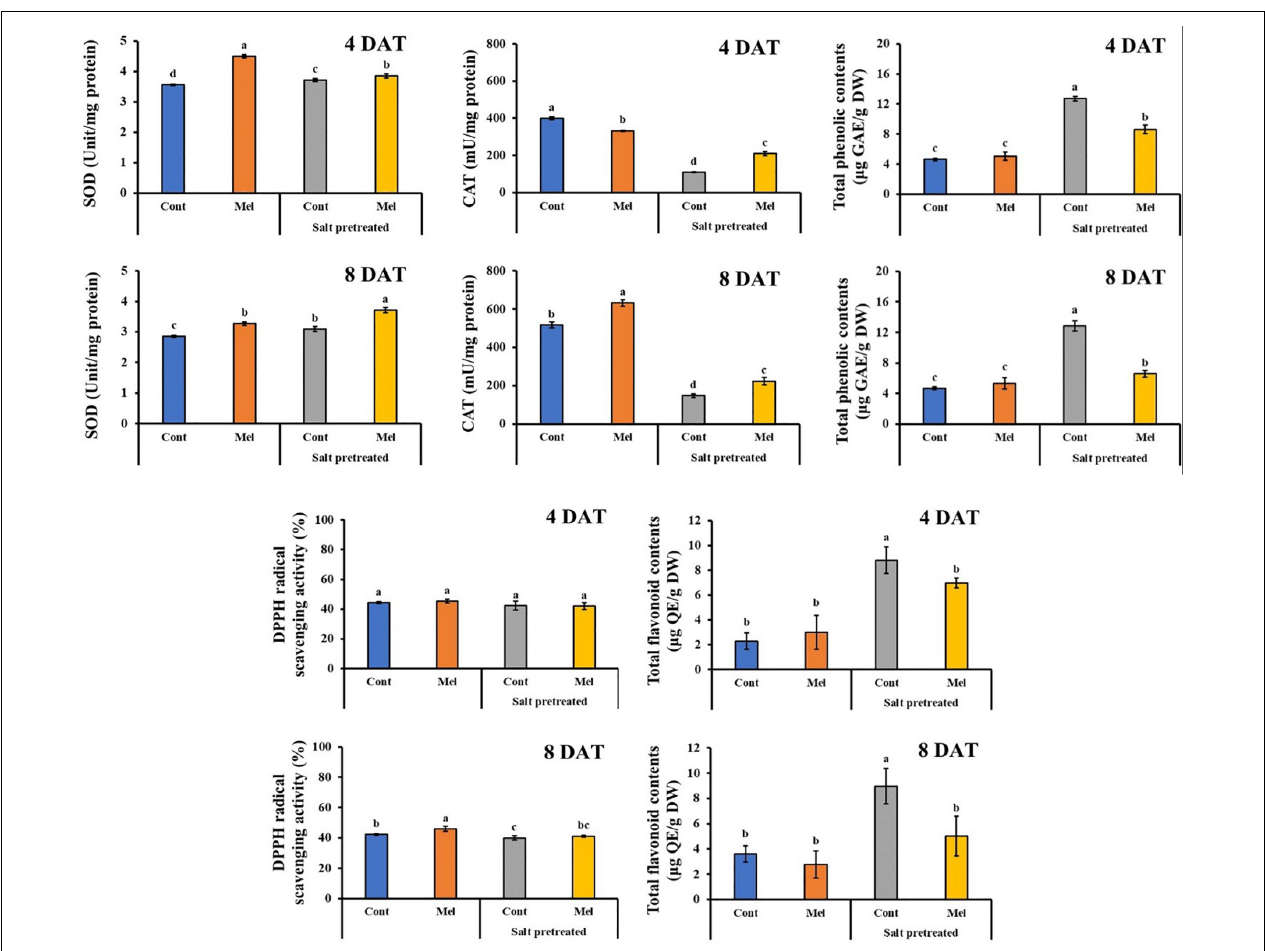
FIGURE 11 | Effect of melatonin with/without salt stress on antioxidant content in green mustard seedlings. The results were calculated from data for 4 (4DAT) and 8 (8DAT) days. Treatment: control + water, control + 1 µ M melatonin, 150 mM salt pre-treatment + water, 150 mM salt pre-treatment + 1 µ M melatonin. Values show the means ± SE ( n = 3). Letters represent significant differences at p < 0.05 in accordance with Duncan’s multiple range